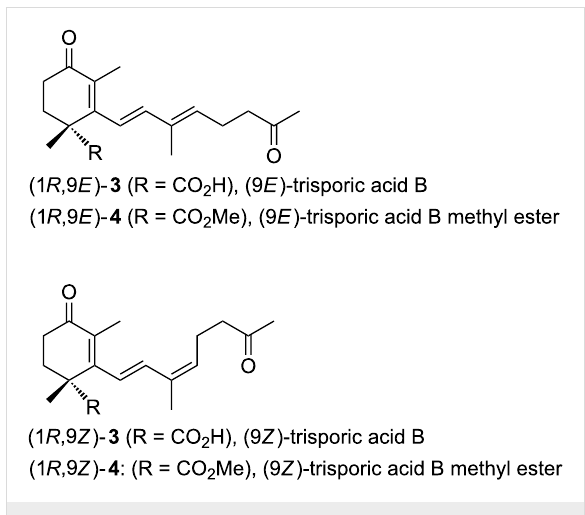
Figure 1: (9 E )- and (9 Z )-trisporic acid